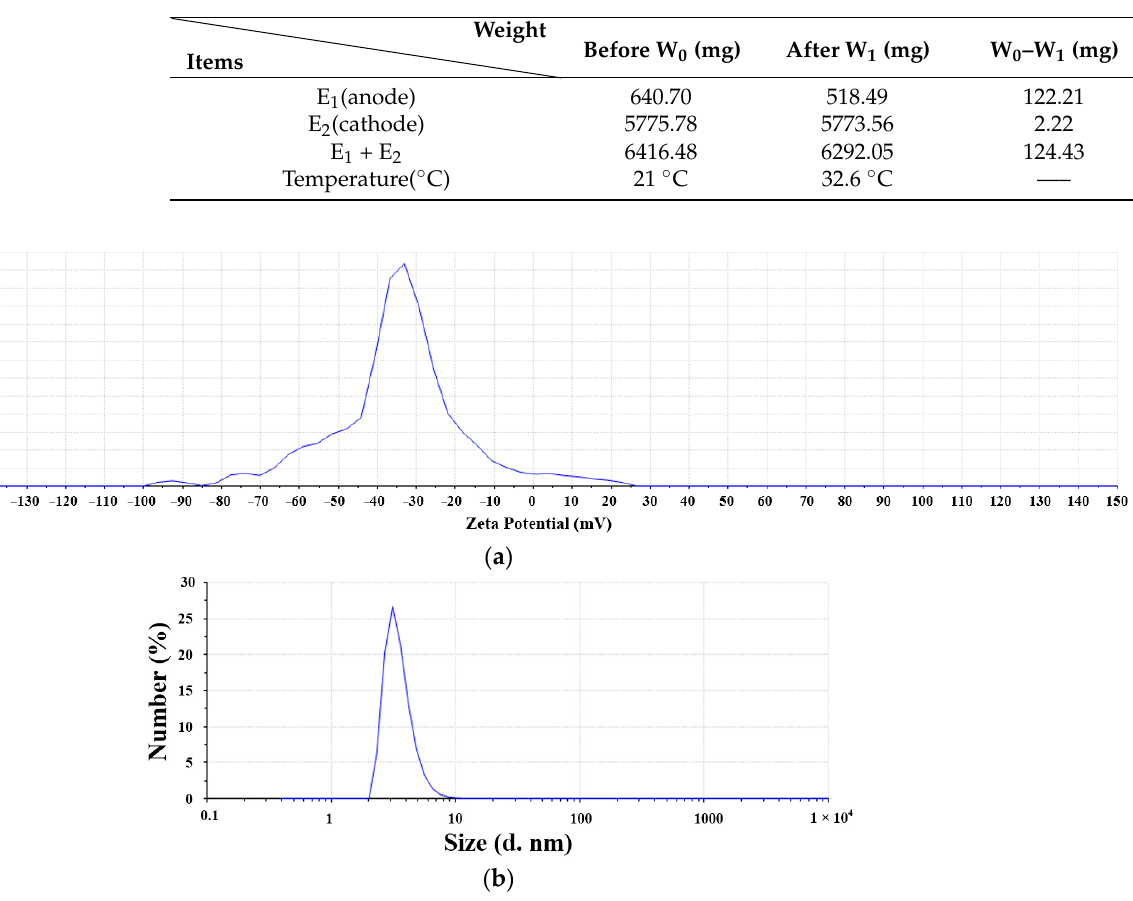
Table 7. Weight loss calculations of the EDM.